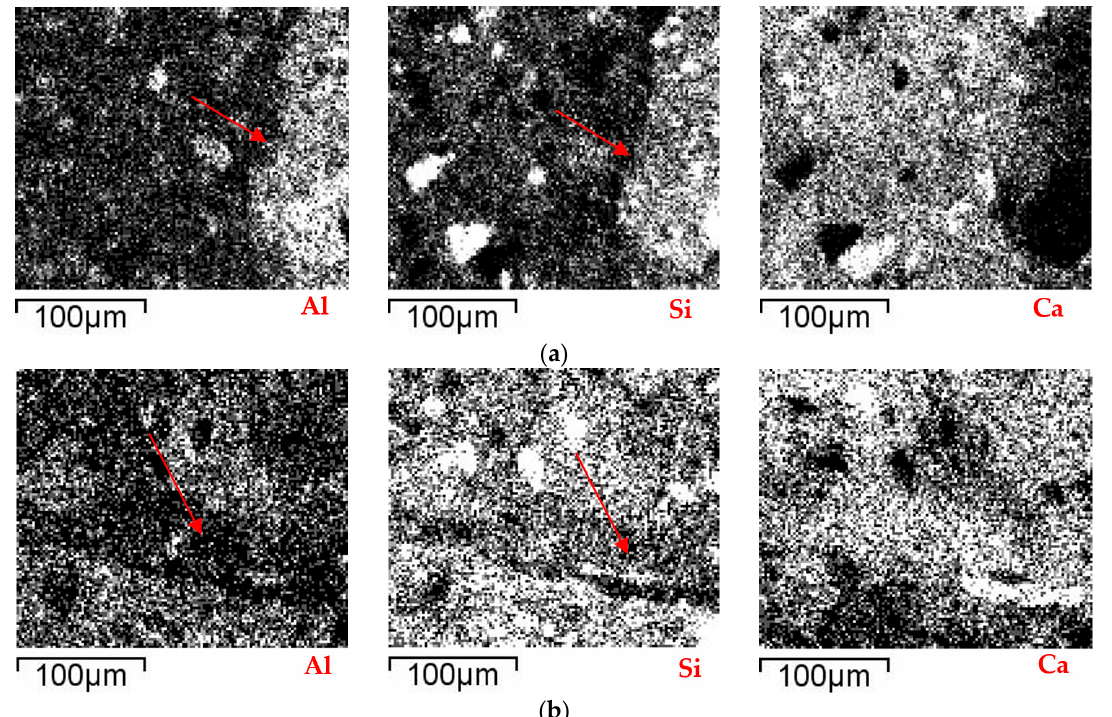
Figure 8. Microanalysis of components by mapping in SEM of the majority compounds: ( a ) RCM50; and ( b ) RCM100.